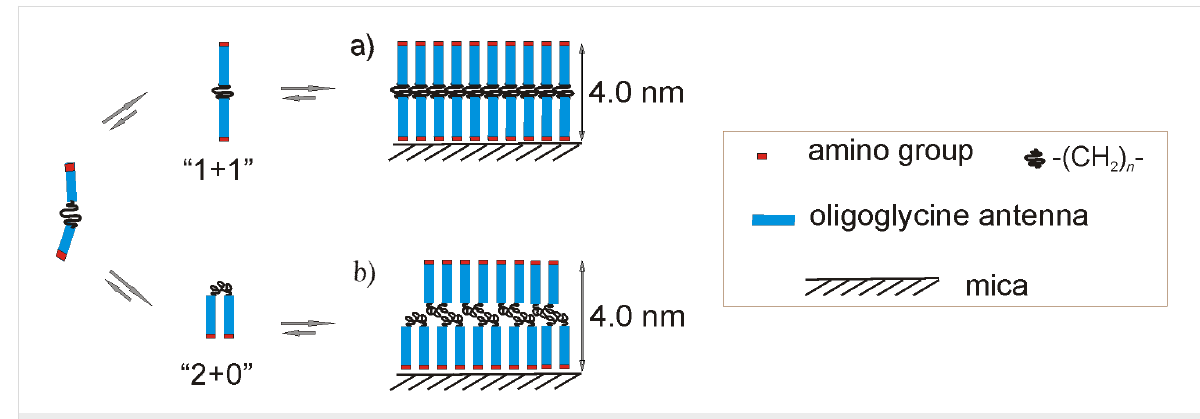
Figure 4: Model of the formation of tectomer layers by biantennary oligoglycines on a mica surface. The heights are given for Н -Gly 4 NH( СН 2 ) 10 NHGly 4 - Н .